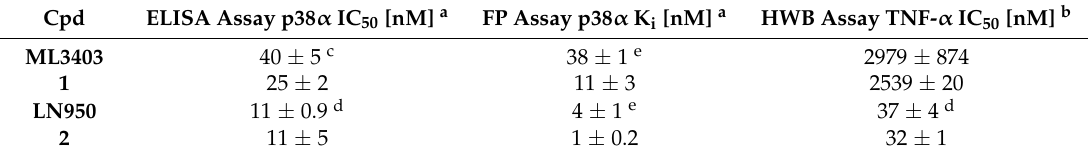
Table 1. Evaluation of trisubstituted imidazoles for their inhibition of p38 α MAP kinase (ELISA assay), their binding affinity to p38 α MAP kinase (FP assay) as well as for their inhibition of TNF- α release in LPS-stimulated human whole blood (HWB assay).